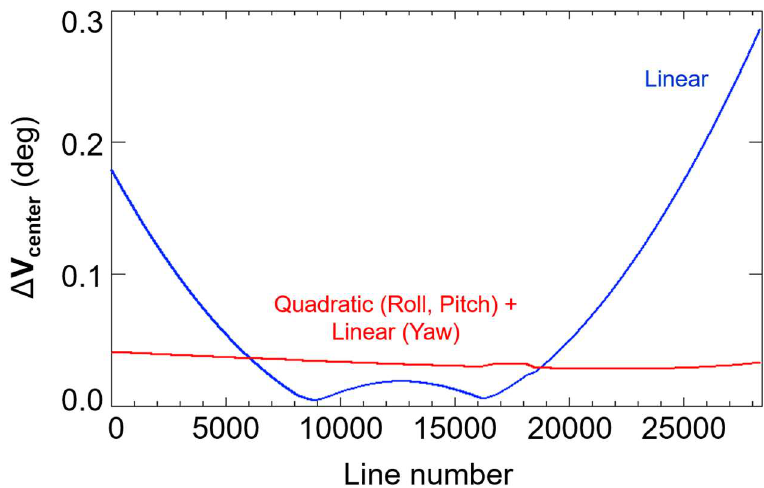
Figure 9. Temporal variations of differences in directions of line-of-sight vectors at the center of ASTER derived from onboard sensors and the proposed method in sequential observations (composed of seven scenes). The blue line shows the result from using only linear equations and the red line is from combining linear and quadric equations.